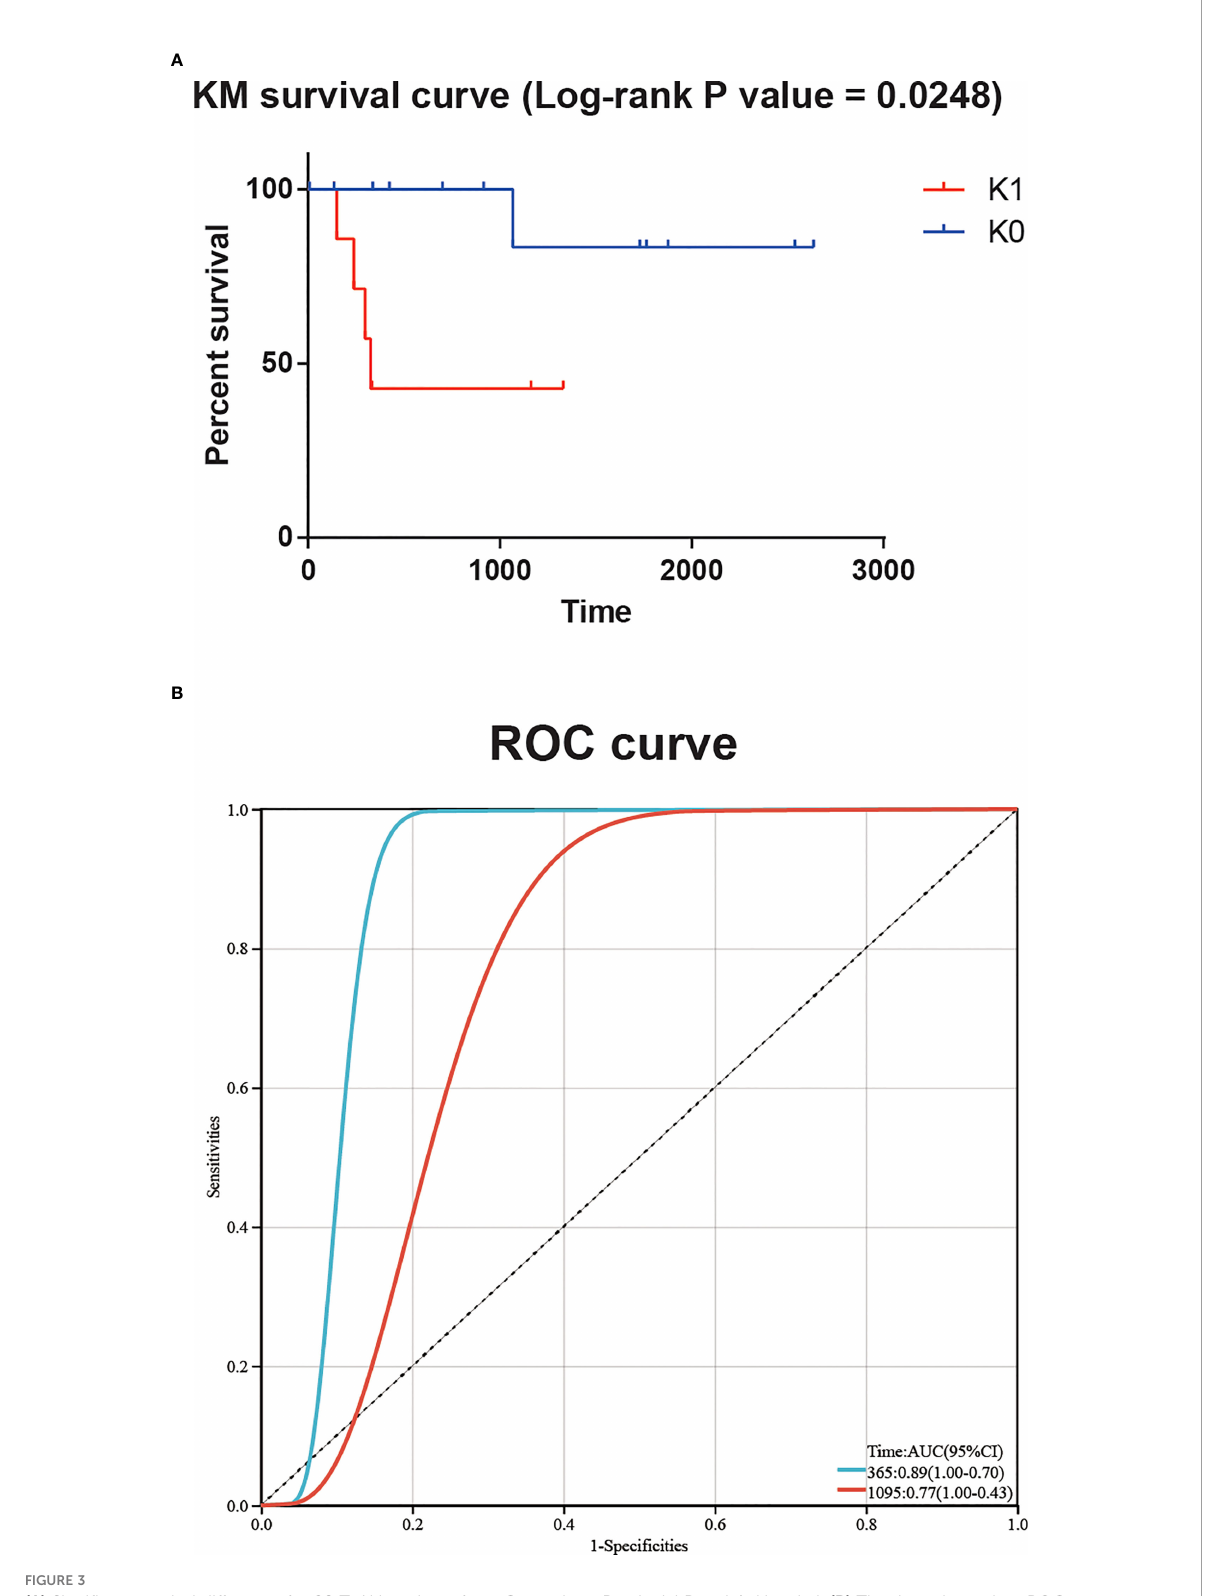
FIGURE 3 (A) Signi fi cant survival difference for 20 T-ALL patients from Guangdong Provincial People ’ s Hospital. (B) The time-dependent ROC curve showed a signi fi cant correlation between patient risk score and survival